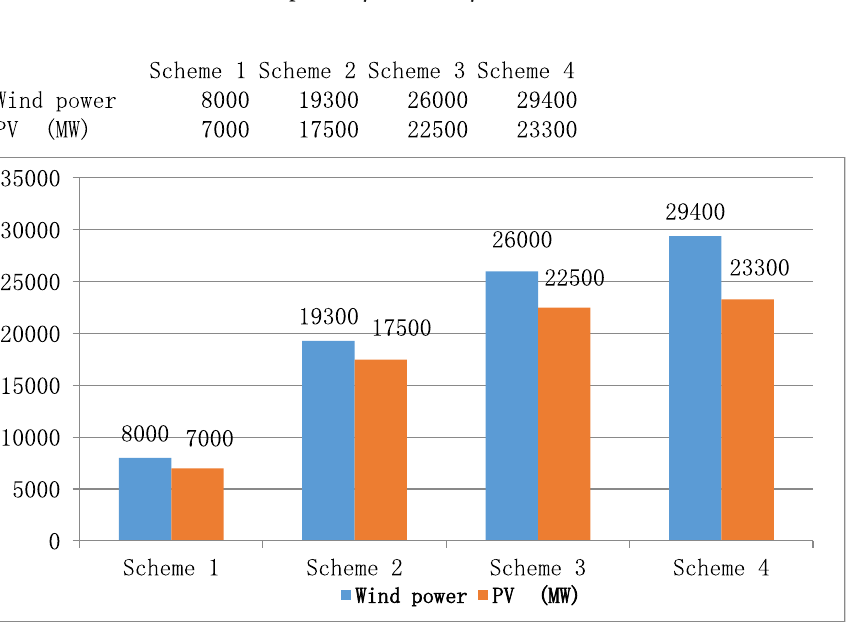
Fig. 8 Wind power and PV power accommodation capacity of North